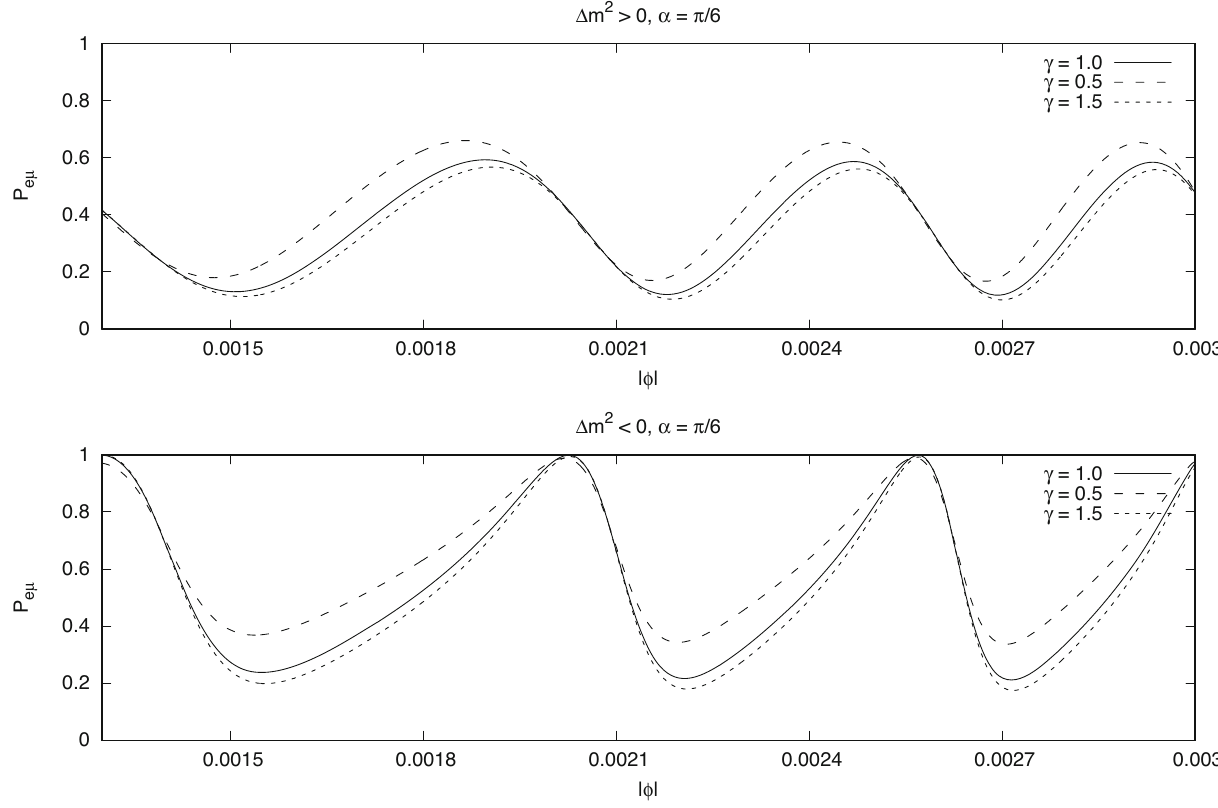
(dashedline)and γ = 1 . 5(dottedline)forinvertedhierarchy (cid:8) m 2 < 0. The mixing angle here is α = π/ 6. Values of the other parameters are as follows: M ADM = 1 M (cid:15) , (cid:8) m 2 = 10 − 3 eV 2 , and the lightest neutrino here is considered to be